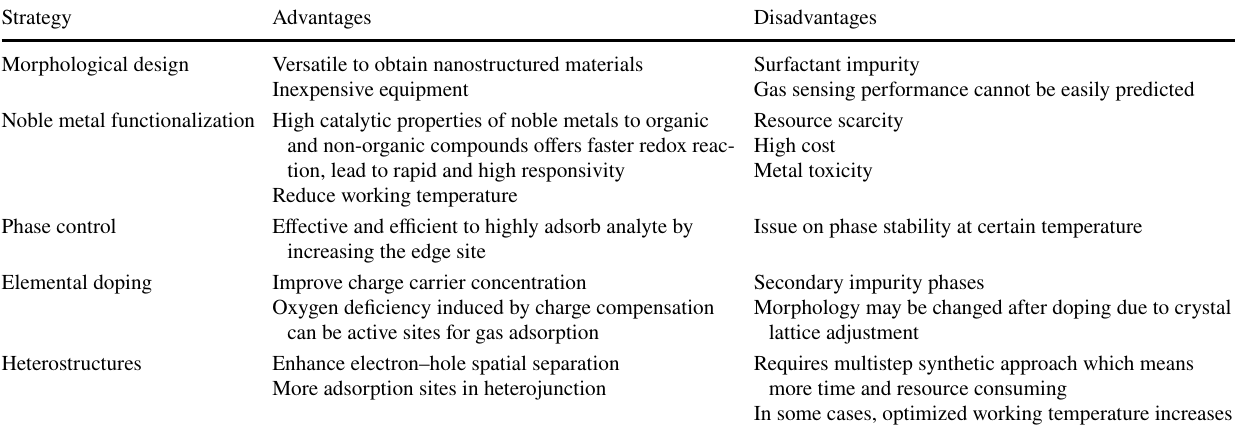
Table 3 Advantages and disadvantages of each improvement strategy